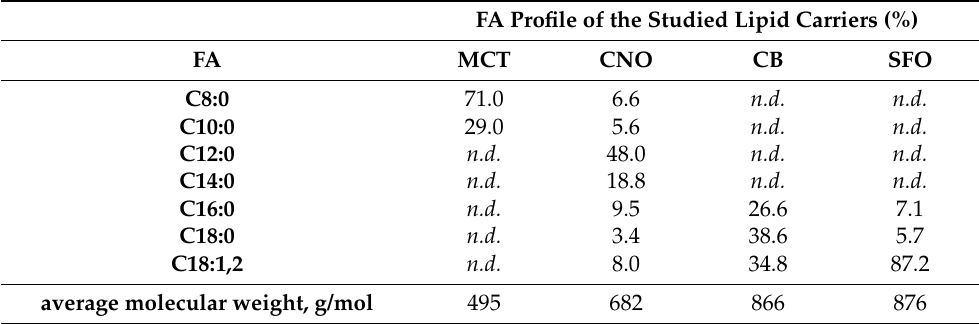
average molecular weight,